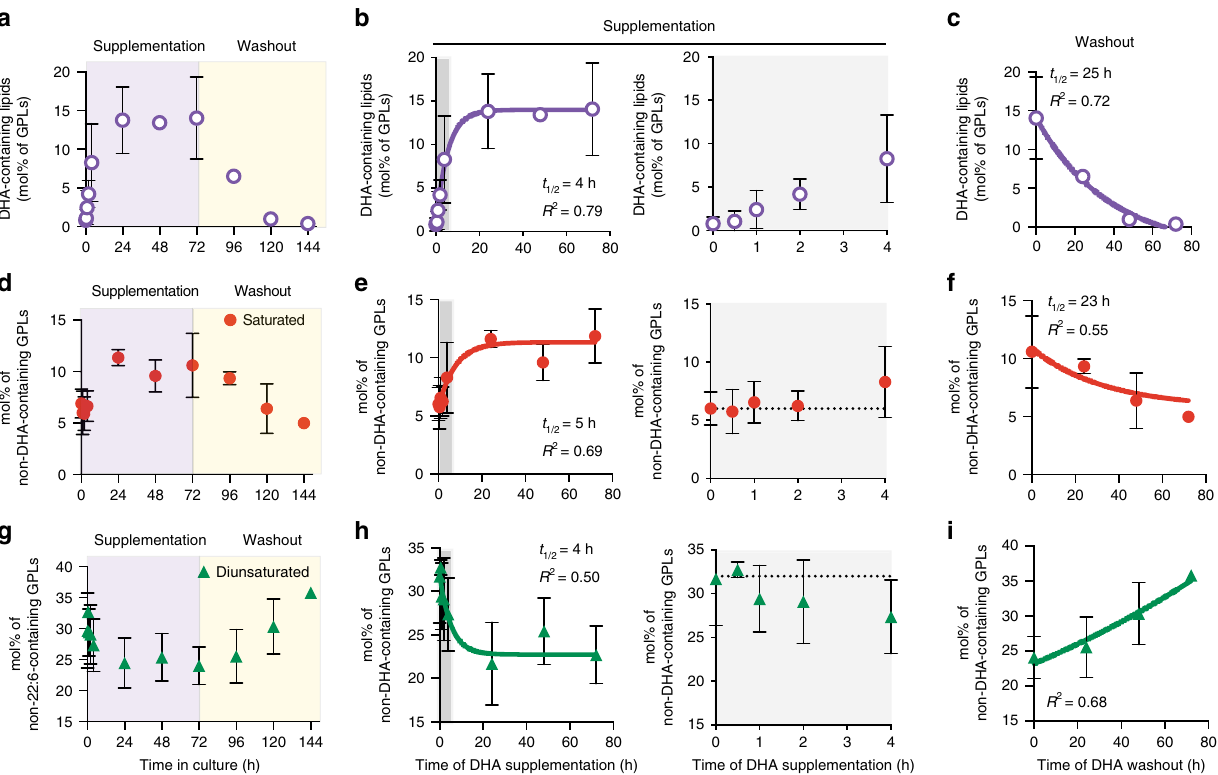
Fig. 3 Time course of DHA incorporation and lipidome remodeling. a – c Time course of DHA incorporation into GPLs following supplementation, then wash-out. Time course of nearly concomitant ( d – f ) saturated lipid and ( g – i ) di-unsaturated lipid changes induced by DHA supplementation. The gray areas in ( b ), ( e ), and ( h ) are shown in extended charts to the right of each panel to illustrate the timing of the remodeling. All data shown are average ±SD for n ≥ 3 biological replicates. All fi ts shown are fi rst-order kinetic models. Source data are provided as a Source Data fi